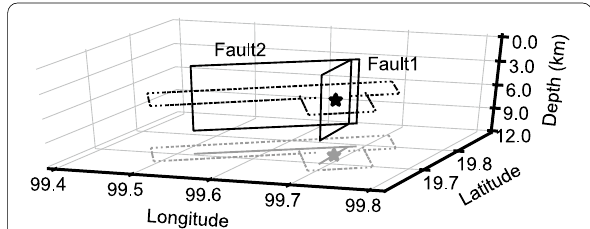
Fig. 4 The 3D view of the input and assumed model geometries. The rectangles are the input fault planes (Fault 1 and Fault 2). The dashed polygon is the assumed horizontal model plane for the potency density tensor inversion. The star shows the initial rupture point. The shadow gray solid line, dotted line, and star are map views of the input and inversion model